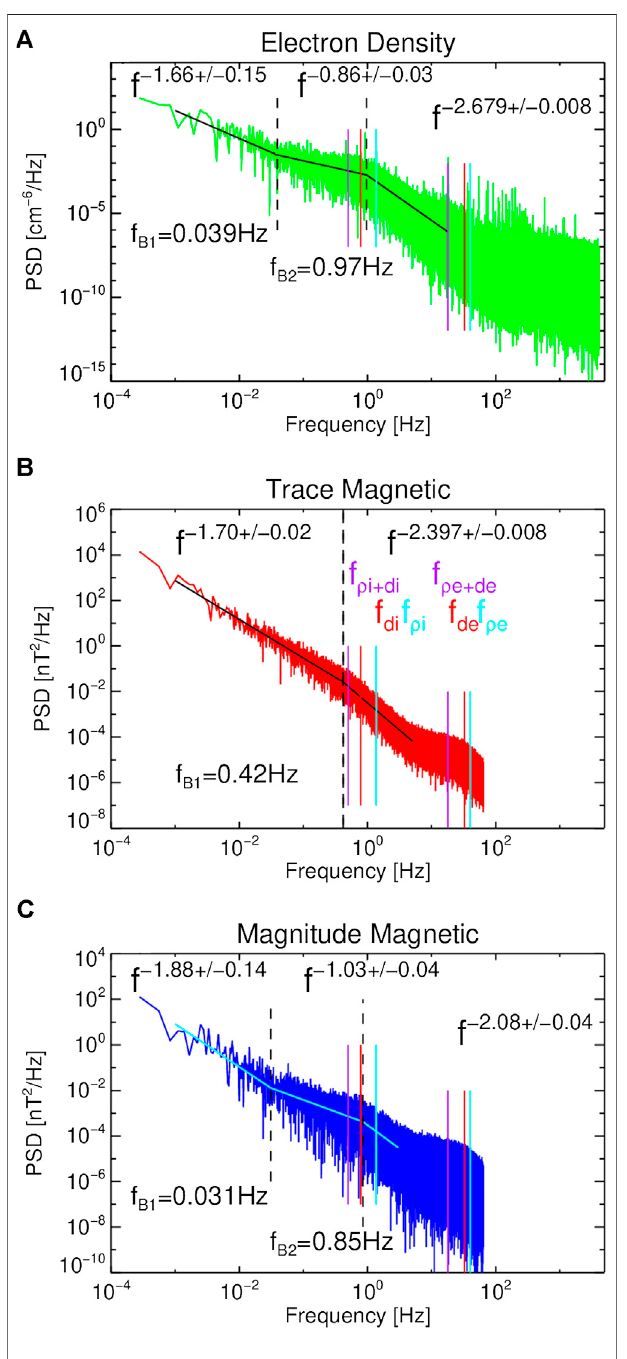
FIGURE 2 | Power spectral densities from MMS1. (A) shows the electron density from the spacecraft potential, (B) shows the trace magnetic fi eld from the fl uxgate magnetometer (C) shows the magnetic fi eld magnitude from FGM. The colored lines denote several of the characteristic scales, while the black dashed lines denote the spectral breaks. The power-law fi ts and the break frequencies are indicated on the plots.